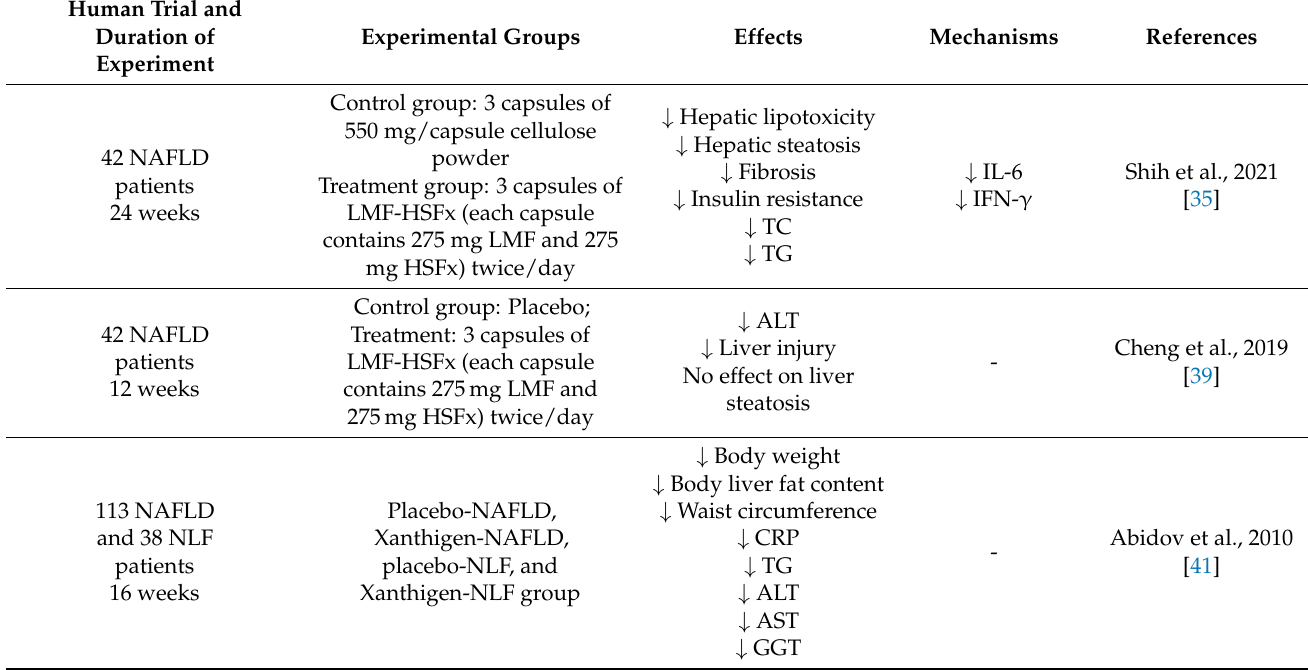
Table 1. Effects of fucoxanthin on NAFLD in human